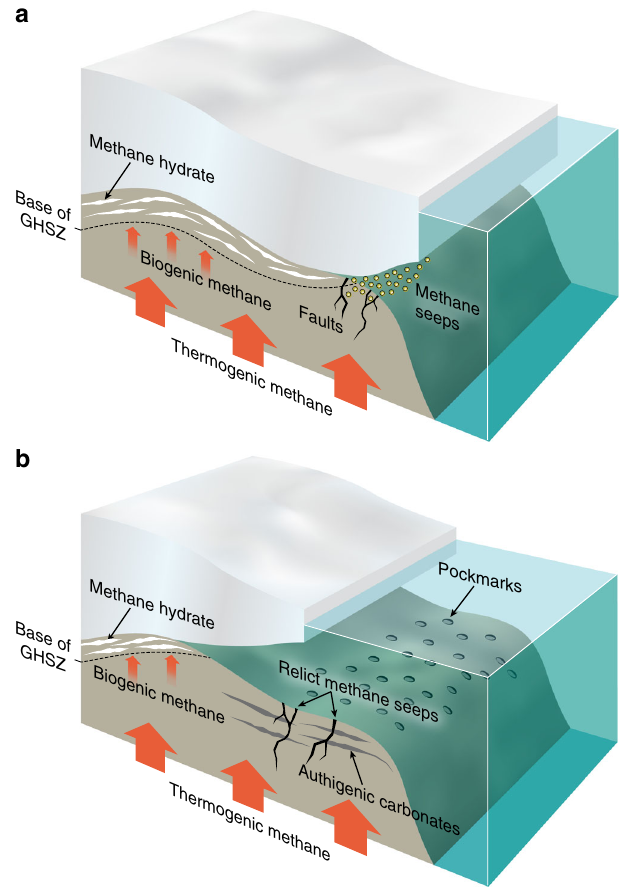
Fig. 6 Model of ice sheet ice sheet impacts on hydrate reserves. A conceptual model illustrates the impact of ice sheet retreat and thinning on hydrate reserves beneath ice sheets, via their impact on the Gas Hydrate Stability Zone (GHSZ). ( a) Conditions at peak glaciation, and ( b ) conditions after substantial ice sheet retreat. Following ice sheet retreat, relict features of hydrate destabilisation (e.g., authigenic carbonates, pock marks and relict cold seeps) may be evident on the formerly glaciated continental